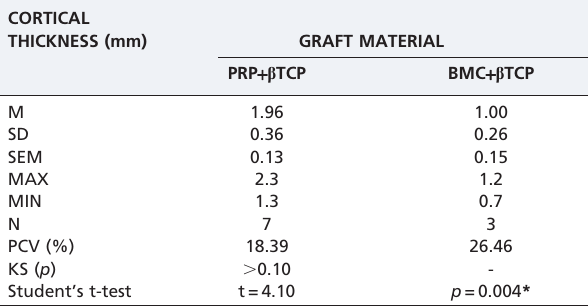
Table 2 - Cortical thickness (mm) formed after bone consolidation in defects filled with PRP + b TCP and BMC + b TCP, measured using computed axial tomography. Normality assessment using Pearson’s Coefficient of Variation (PCV) and the Kolmogorov-Smirnov test (KS). Comparison between grafts using Student’s